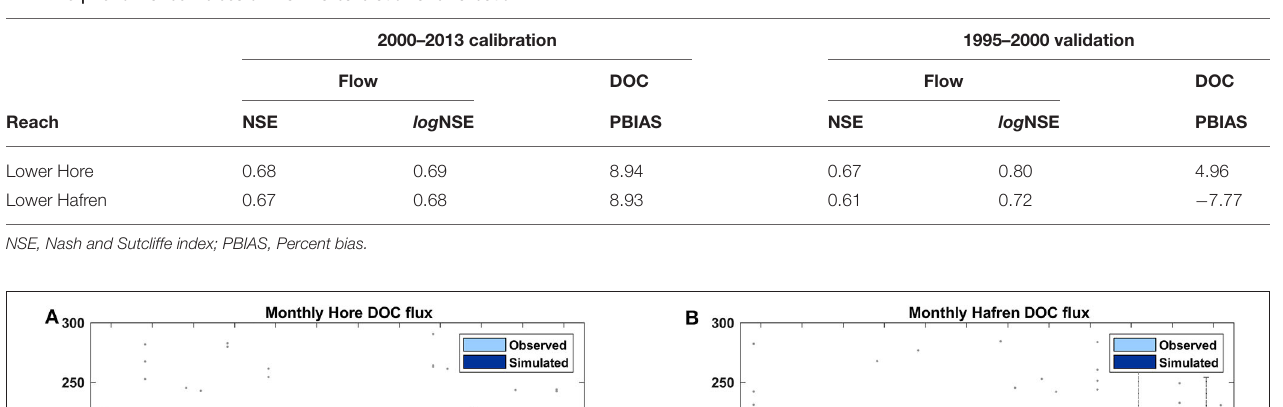
TABLE 3 | Performance indices of INCA -C calibration and validation.